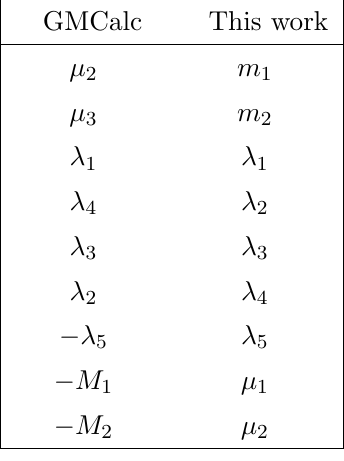
Table 2 . GMcalc convention vs our